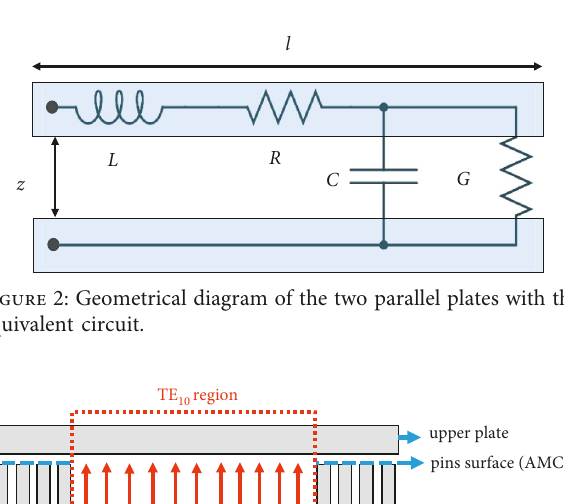
Figure 1: Proposed configurations. (a) Ridge GW. (b) Pothole GW. (c) Inverted-microstrip GW. (d) Microstrip-ridge GW [29].